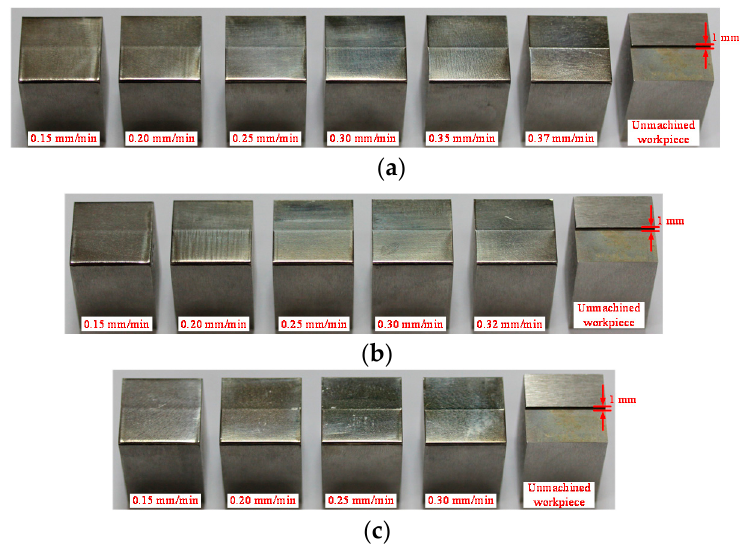
Figure 14. Corresponding workpieces for the three coupling modes. ( a ) Workpieces with different feed rates in the pre-position coupling mode. ( b ) Workpieces with different feed rates in the symmetry coupling mode. ( c ) Workpieces with different feed rates in the post-position coupling mode.